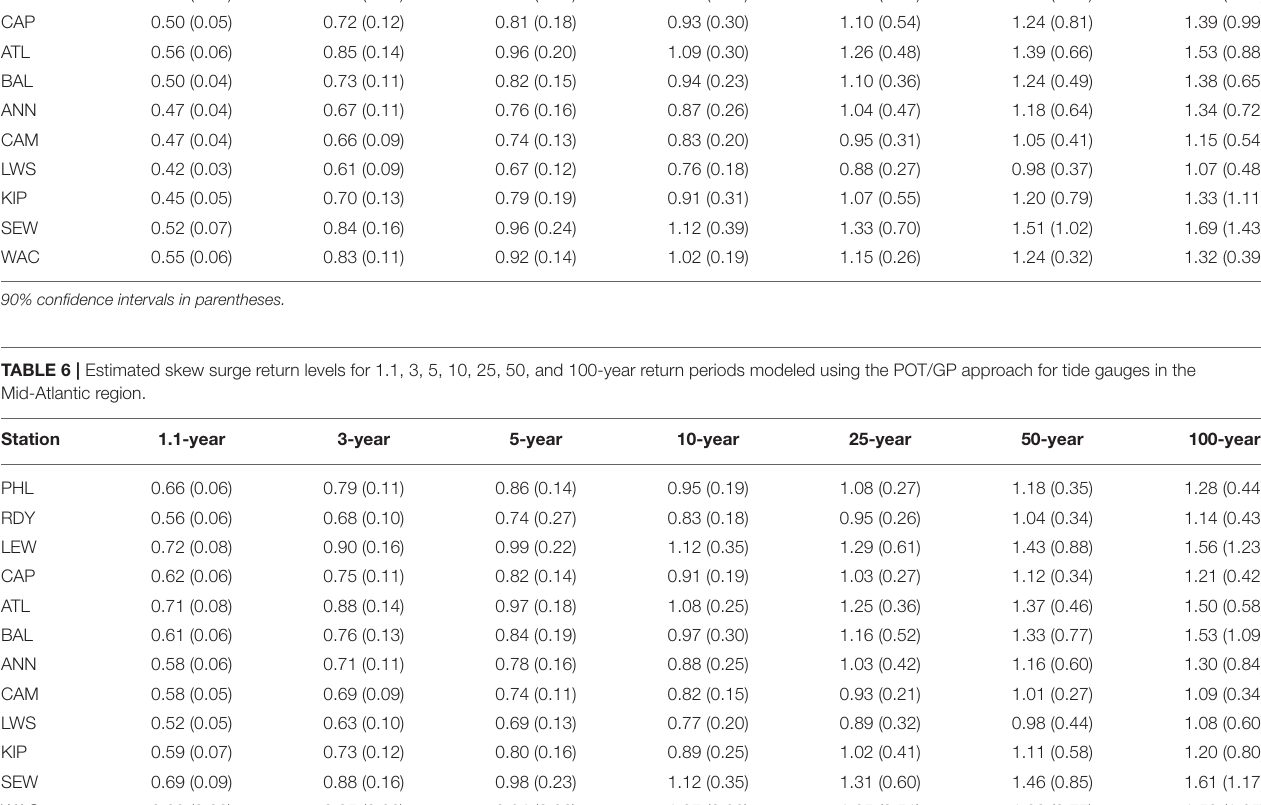
TABLE 5 | Estimated skew surge return levels for 1.1, 3, 5, 10, 25, 50, and 100-year return periods modeled using the BM/GEVr approach for tide gauges in the Mid-Atlantic region. Station